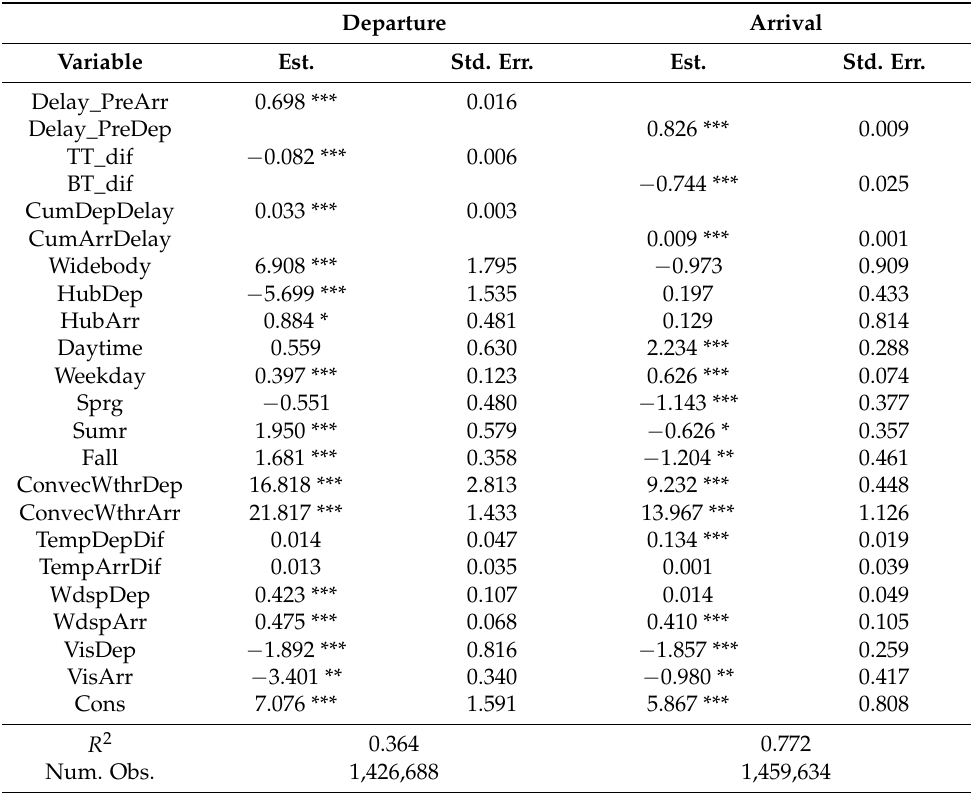
Table 3. Base models for flight delays for both departure and